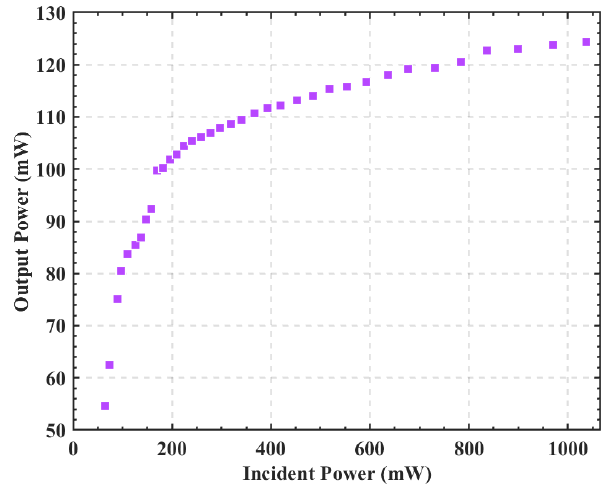
Figure 4. Output power of the NOL based on the 50 m HNLF.